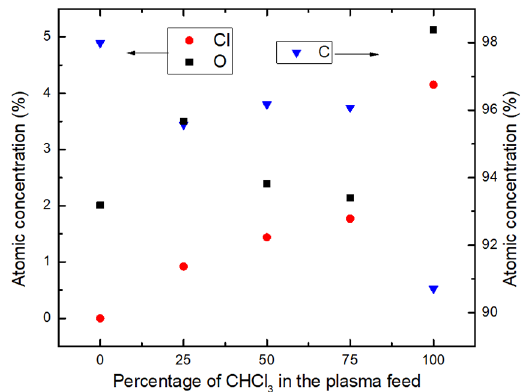
Figure 4. Elemental composition determined using EDS as a function of C